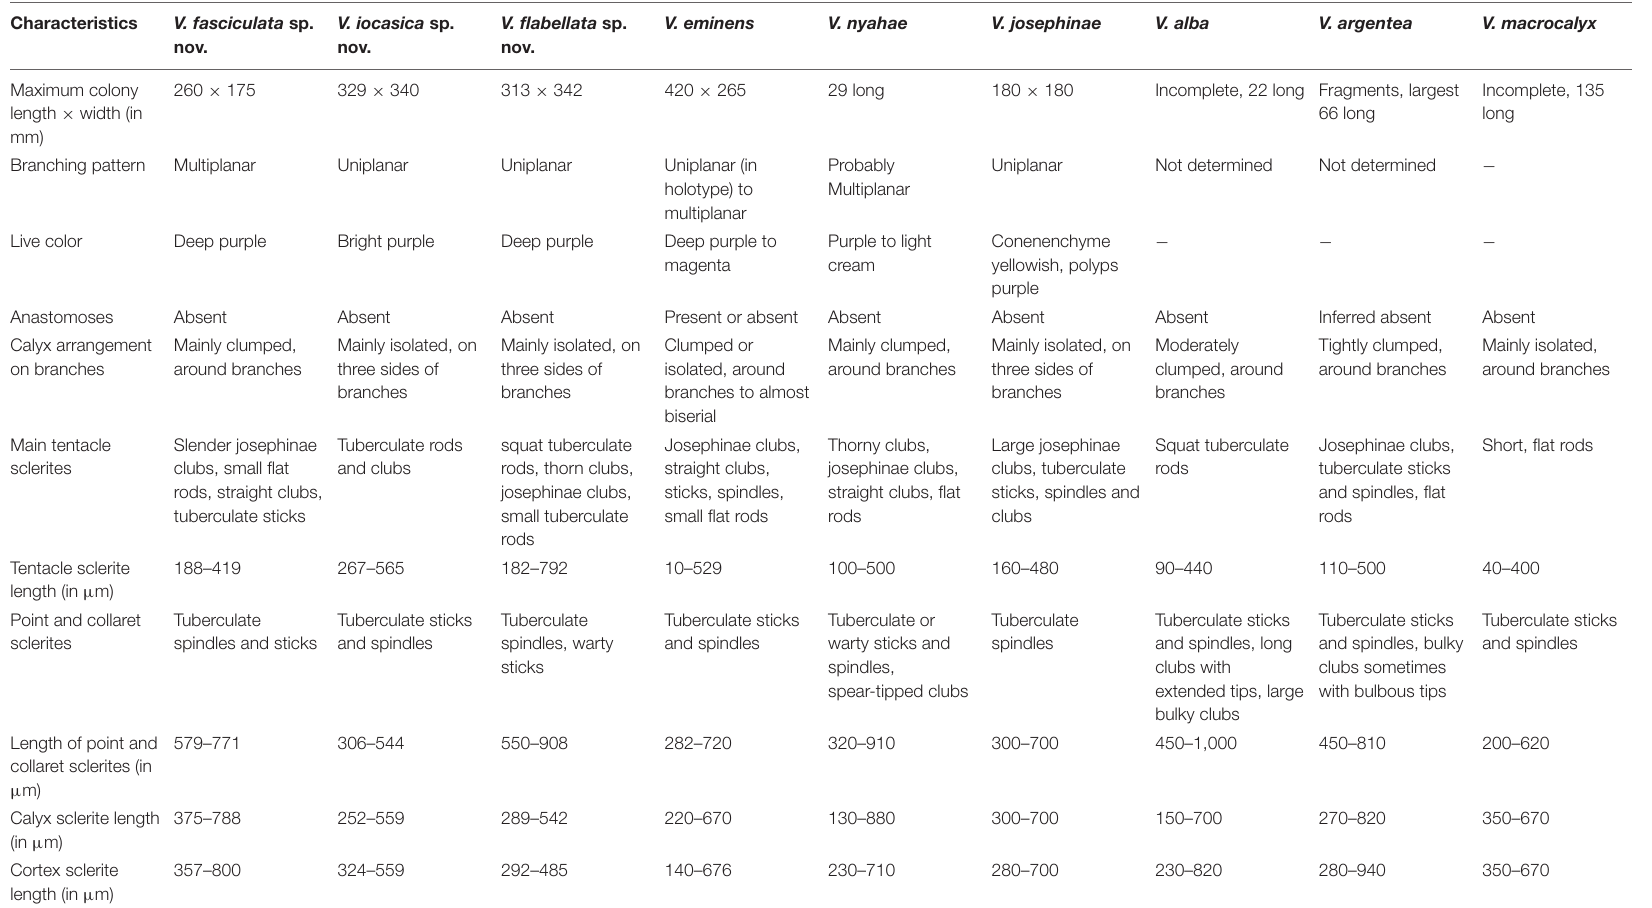
TABLE 2 | Comparison of species of Victorgorgia López-González and Briand,